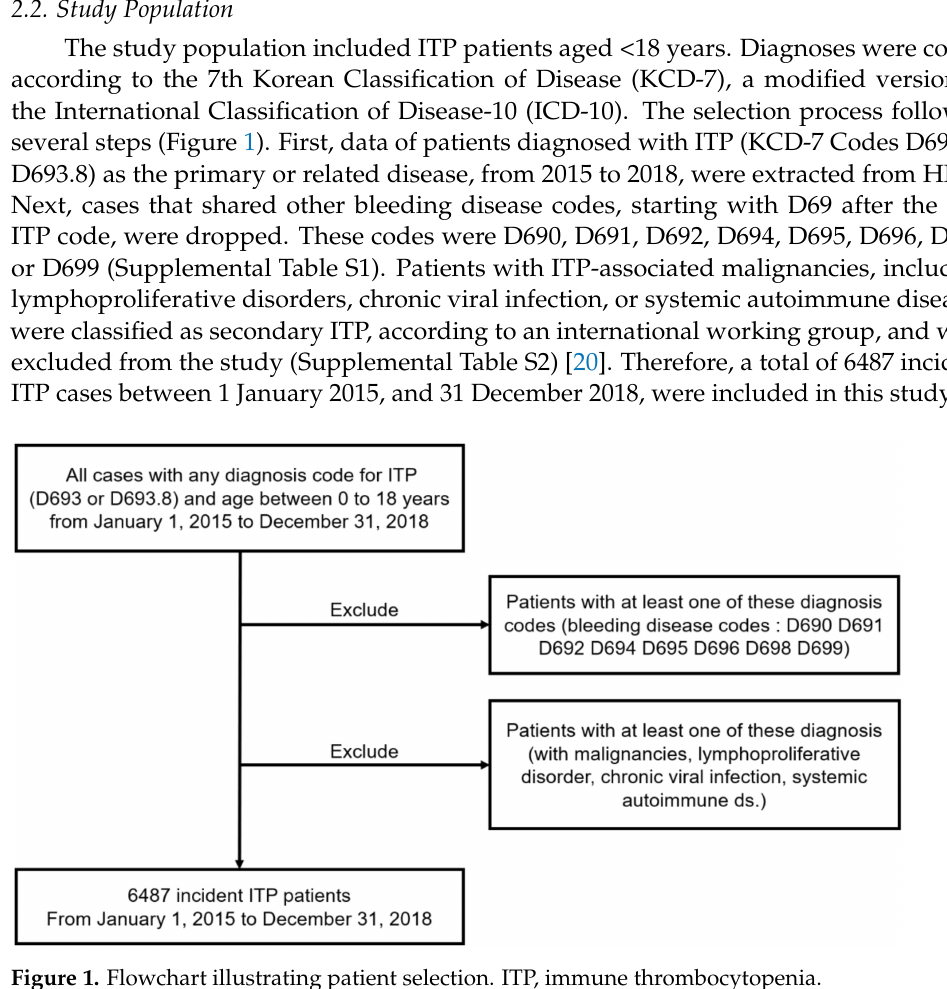
Figure 1. Flowchart illustrating patient selection. ITP, immune